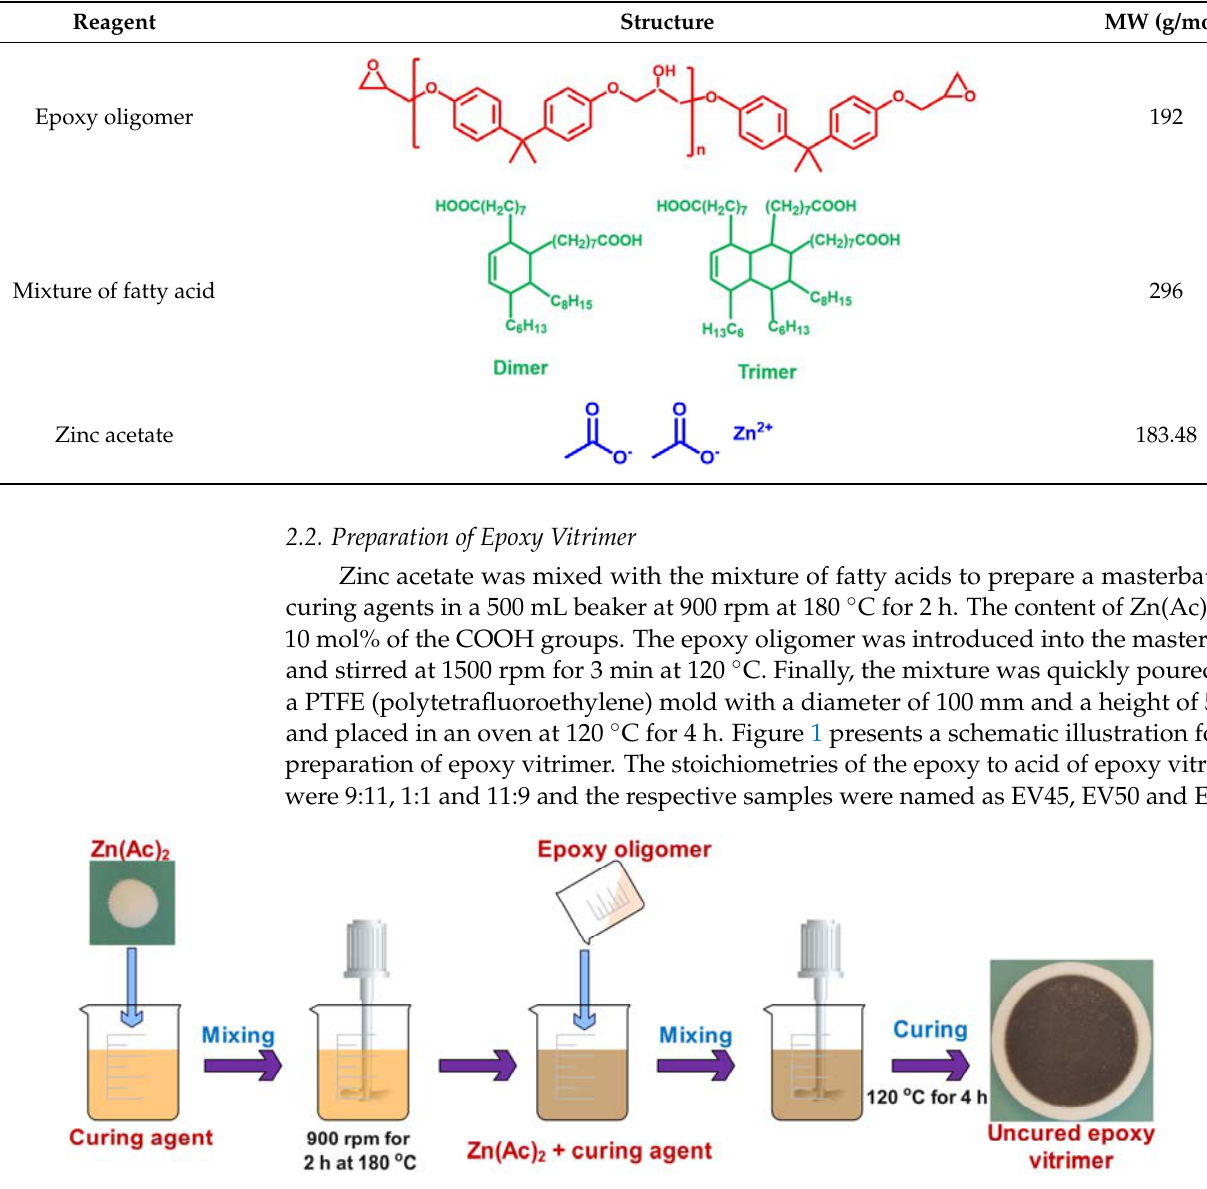
Figure 2. Schematic illustration for the recycling of vitrimer. 2.4. Methods Tensile tests were conducted on an Instron 3366 testing machine according to ASTM D638 (type V). The dumbbell ‐ shaped samples were tested at room temperature. The cross ‐ head speed during measurements was 200 mm/min. At least five samples were measured for each composition. DMA was carried out on a DMA + 450 dynamic mechanical analyzer (01 dB Metravib, France). The samples with dimensions of 30 × 20 × 2.5 mm 3 were mounted on a tension clamp and tested at a ramping rate of 3 °C/min and a frequency of 1 Hz from − 25 to 125 °C. The T g was determined as the temperature of the maximum damping factor (tan δ ) value in a tan δ versus temperature curve. Isothermal and dynamic DSC analyses were performed on a DSC 1 instrument (Mettler ‐ Toledo, Switzerland) under a nitrogen